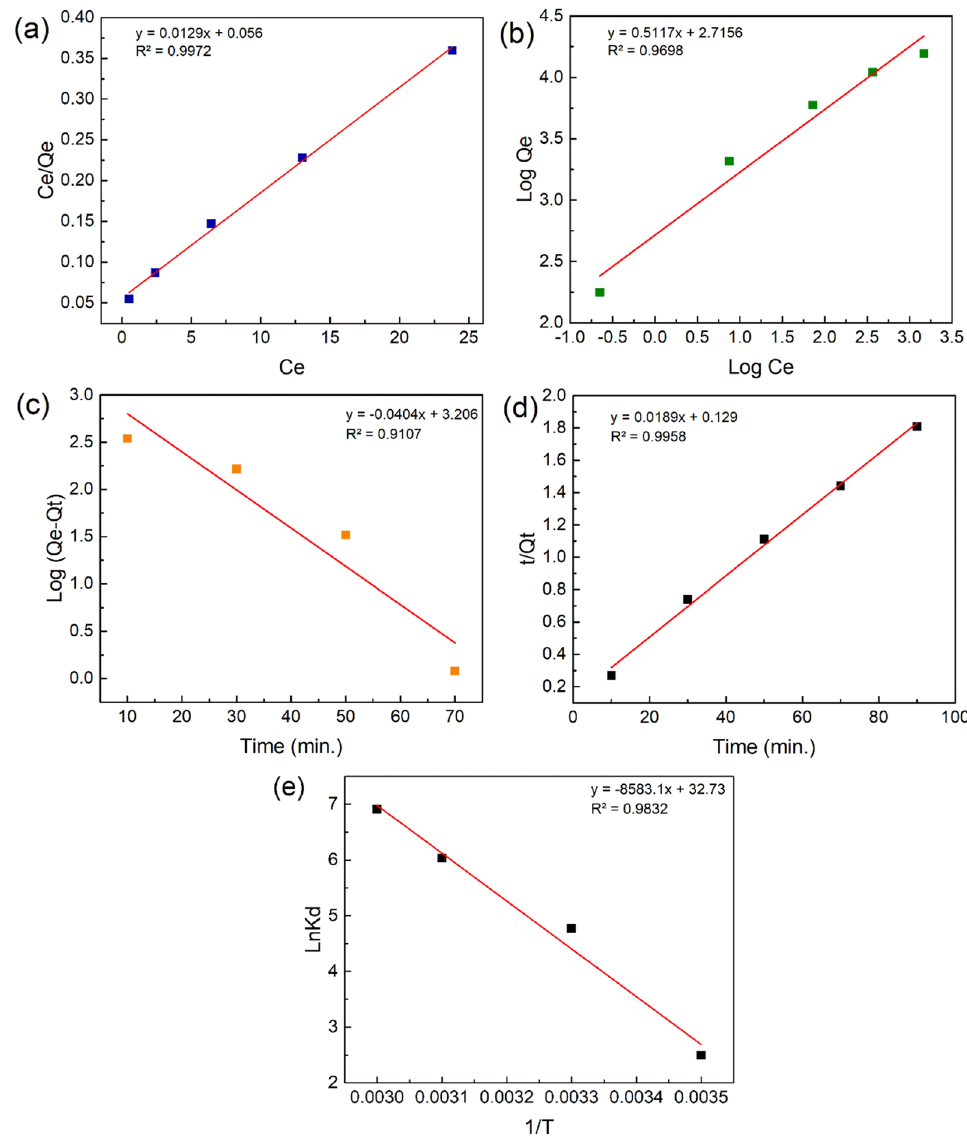
Figure 5. The Langmuir ( a ) and Freundlich ( b ) isotherm models (lead (II) initial concentration: 10–90 mg/L, adsorbent dosage: 60 mg, pH: 6, T: 298 K, and agition time: 90 min); Pseudo-first-order ( c ) and pseudo-second- order ( d ) kinetic models (lead (II) initial concentration: 90 mg/L, adsorbent dosage: 60 mg, pH: 6, T: 298 K, and agition time: 30–90 min); and thermodynamic model ( e ) (Temperature: 288–328 K; adsorbent dosage: 60 mg; pH: 6, lead (II) initial concentration: 90 mg/L; agitation time: 90